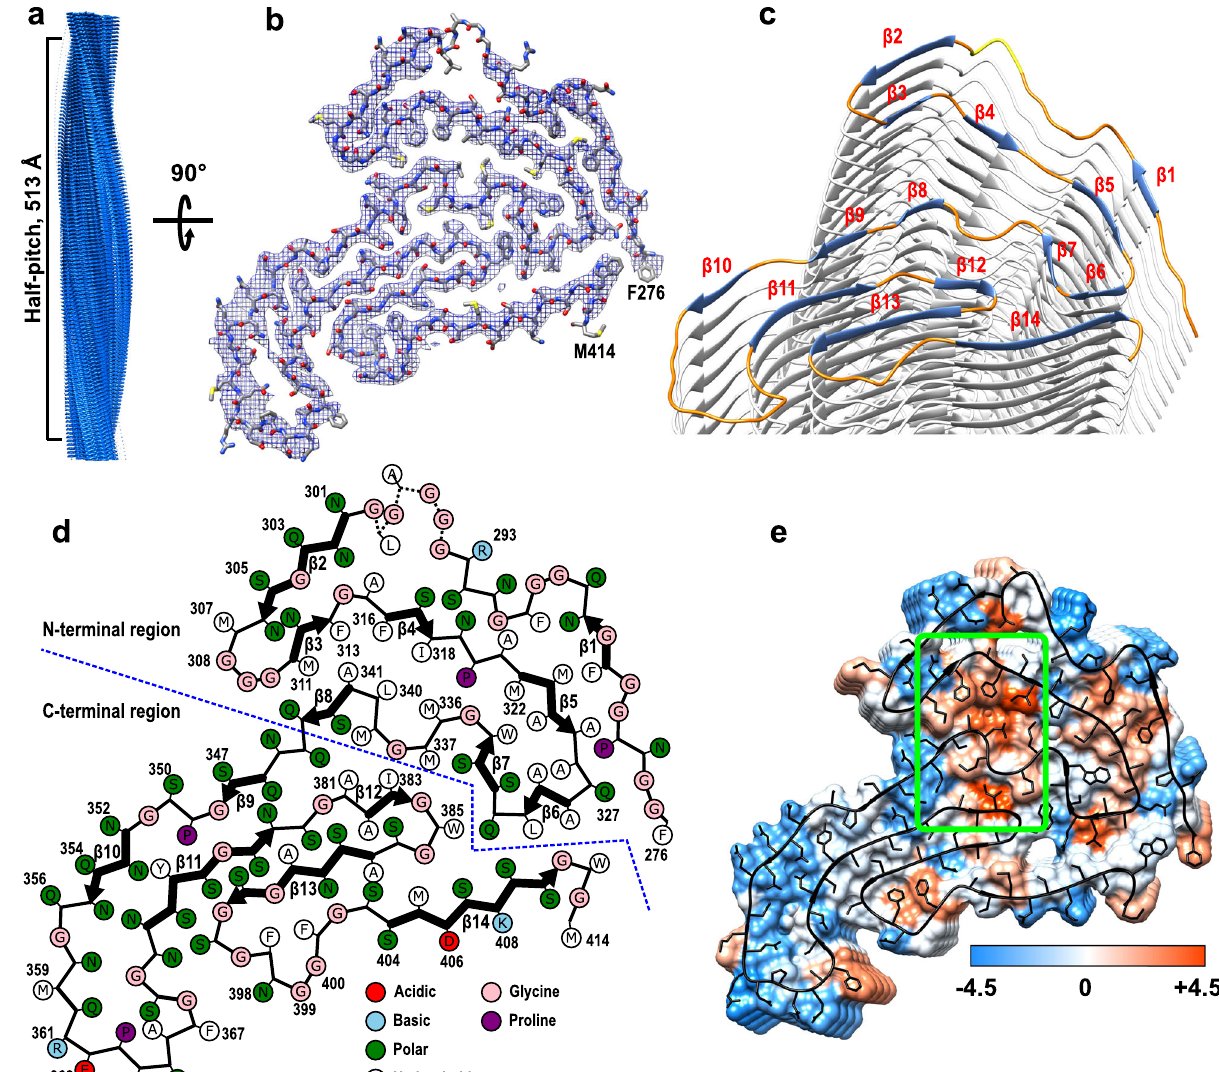
Fig. 1 Cryo-EM structure of TDP-43 LCD fi brils. a Cryo-EM density map showing a left-handed helix with a half-pitch of 513 Å. Repeating densities representing β -strands along the z -axis with a 4.73-Å interval indicate a parallel in-register β -sheet architecture. b The atomic model and superimposed cryo-EM map of one cross-sectional layer of each fi bril (top view). c Tilted cross-section of a TDP-43 LCD fi bril. β -Strands in the top subunit are shown in blue, highly ordered turns in orange, and the less ordered region in yellow. d Schematic representation of one cross-sectional layer of the amyloid core, with β -strands shown as thicker arrows and the less ordered region (residues 295 – 299) marked as dotted lines. e Hydrophobicity of the fi bril cross-section, with hydrophobicity levels colored according to Kyte – Doolittle 54 . A major hydrophobic core (green box) is made up of the 311 – 318, 336 – 341, and 381 – 383